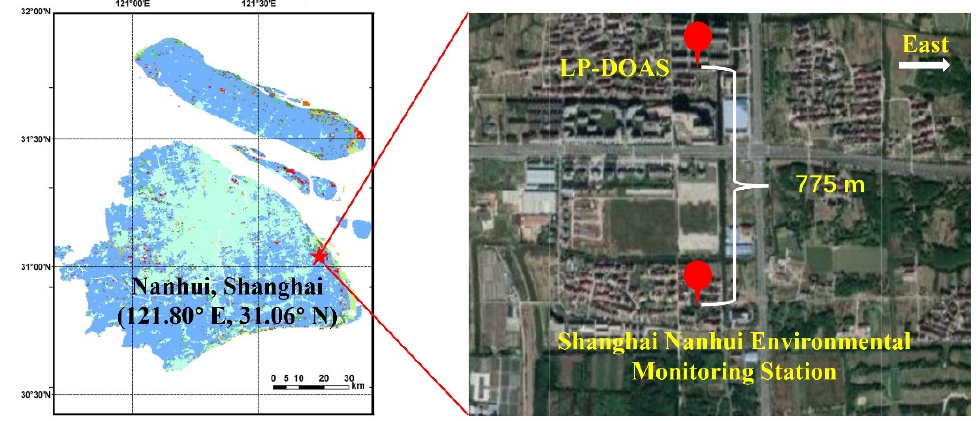
Figure 1. The topographic locations of the LP-DOAS instrument and Shanghai Nanhui Environmental Monitoring Station (© Google Earth).